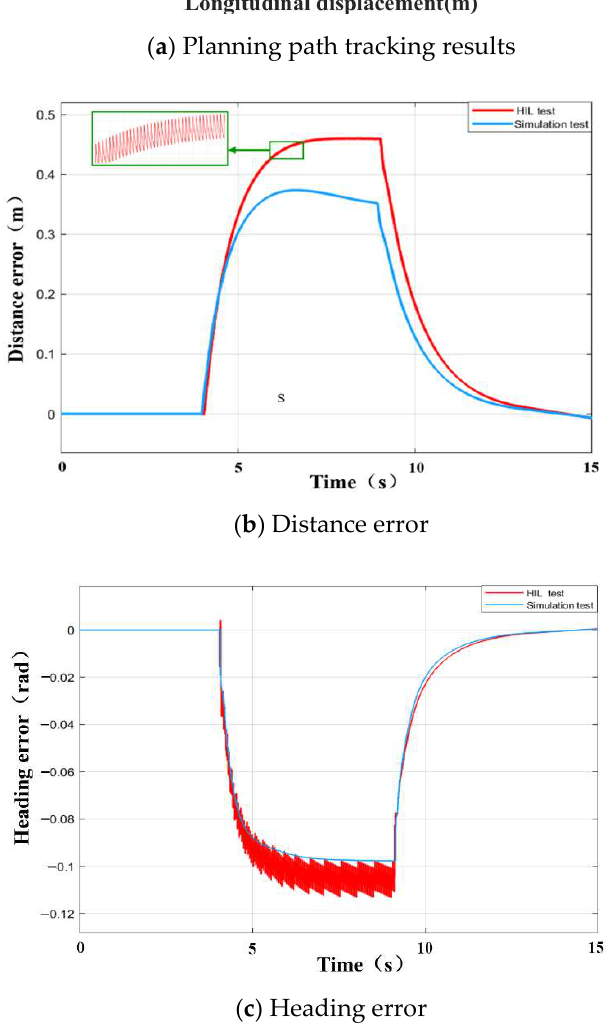
Figure 14. Hardware in the loop test results under roundabout conditions.